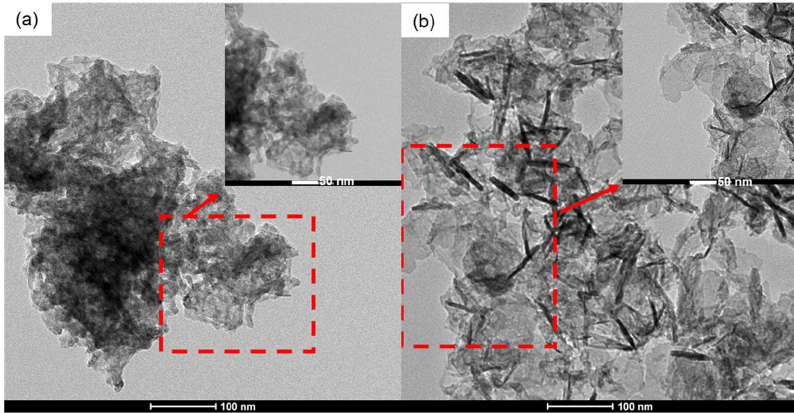
Figure 3. TEM micrographs of the ( a ) MnB−I and ( b ) MnB−II nanoflakes.